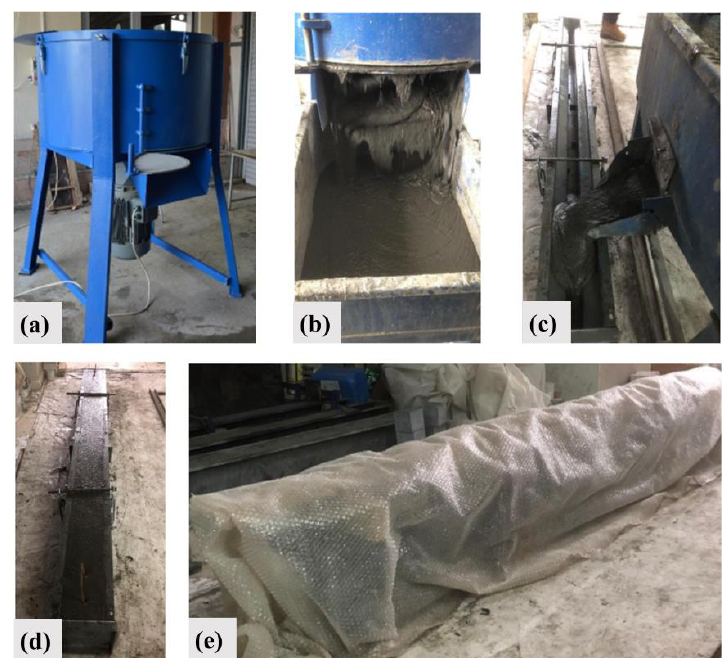
Figure 1. ( a ) Horizontal pan mixer, ( b ) Pouring, ( c ) Casting process, ( d ) After casting, ( e ) Covered beam.